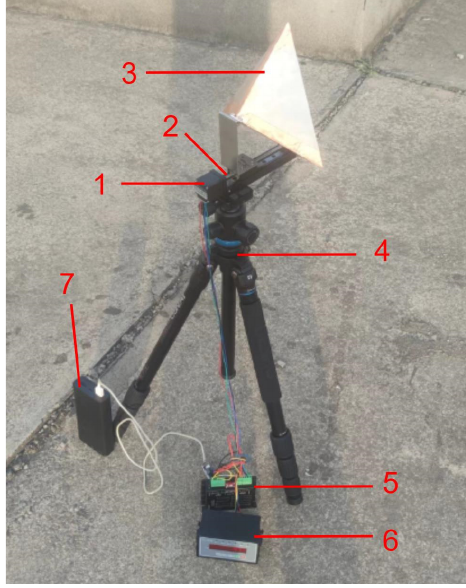
Figure 10. The illustration of the programmable moving corner reflector. Part 1 shows the stepping motor. Part 2 is a high-accuracy screw rod. Part 3 demonstrates the corner reflector. Part 4 express tripod. Part 5 is the controller. Part 6 shows the programmer. Part 7 is a